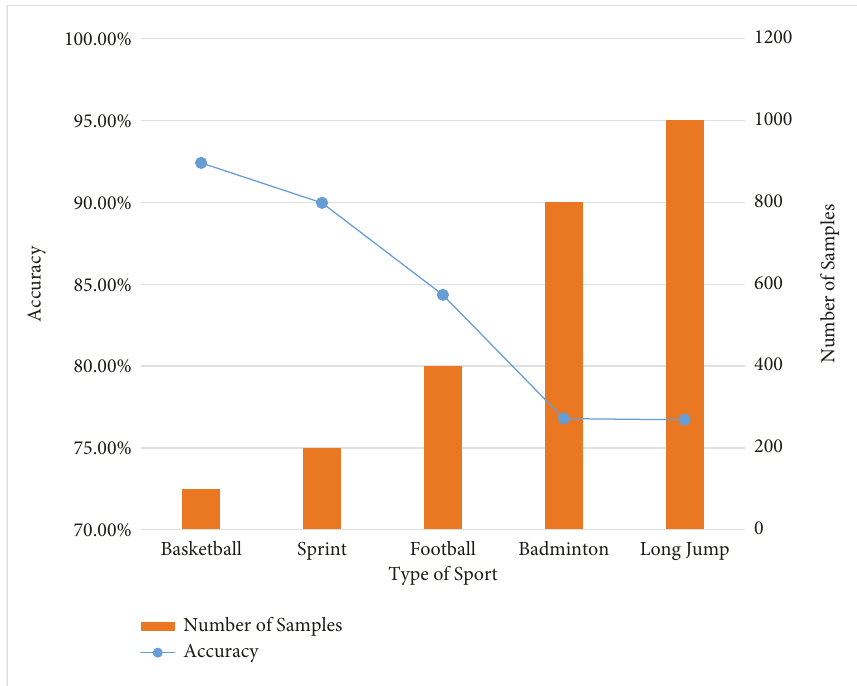
Figure 8: Accuracy of test results with different number of samples.